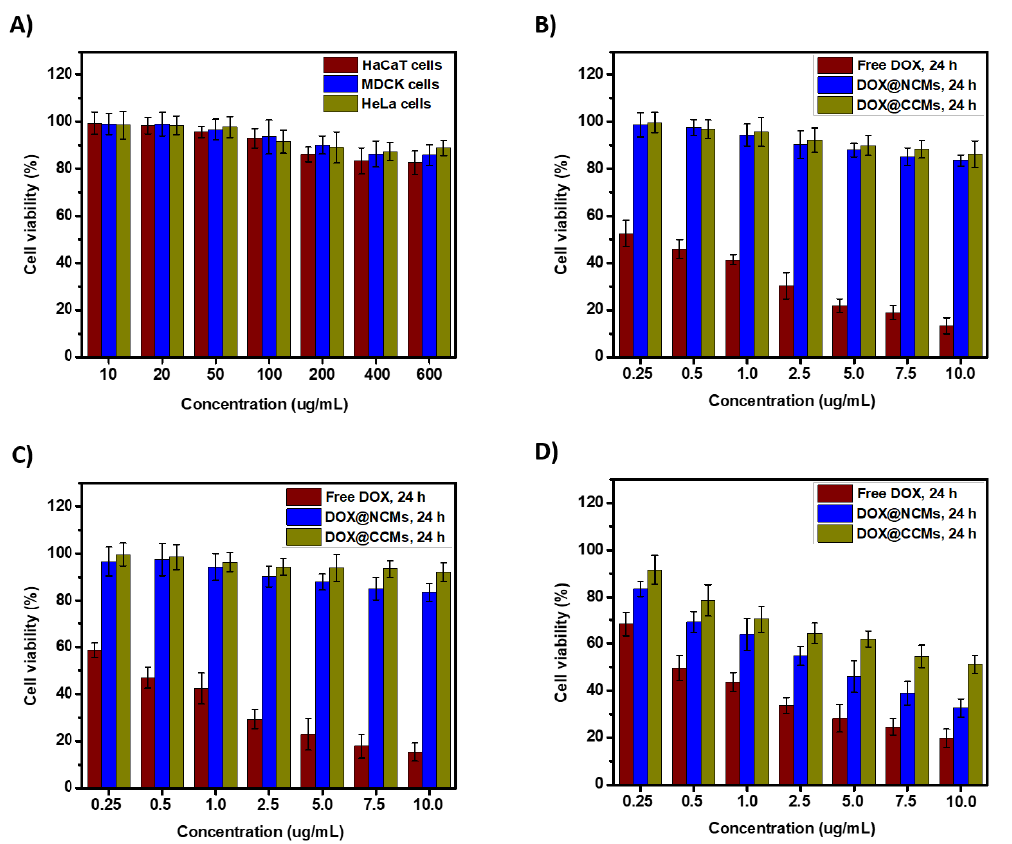
Figure 6. Cytotoxicity of mPEG-P(LA-DSeDEA)-PCL in HaCaT, MDCK, and HeLa cells ( A );